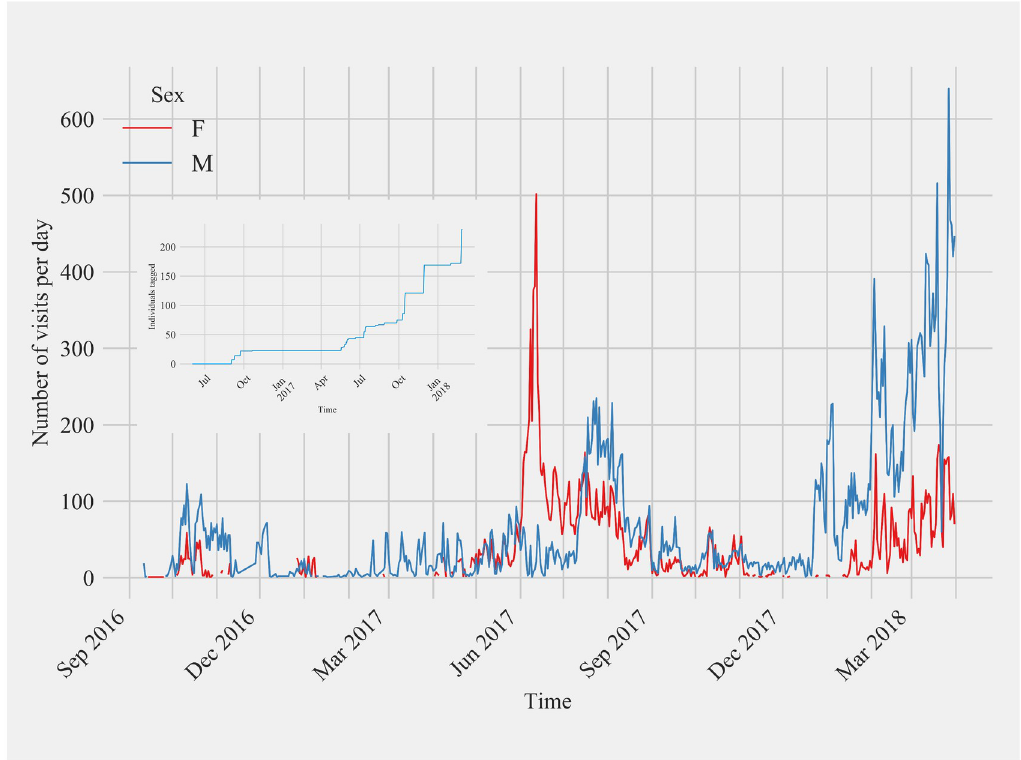
Fig 6. Daily visitations of passive integrated transponder tagged male and female Anna’s Hummingbirds at the feeding stations at Sites 1 and 2 in Northern California and Site 3 in Southern California from September 2016 to March 2018. Inset: The cumulative tagging effort throughout the